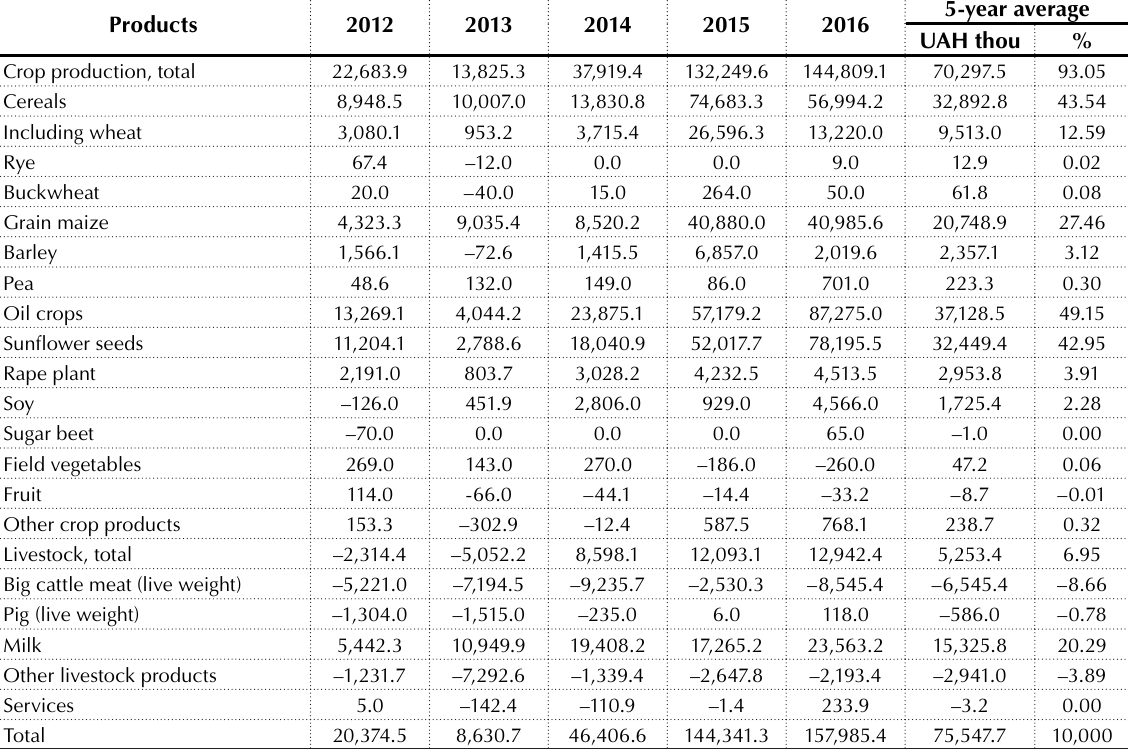
Table 9. Dynamics and distribution of profit received by agricultural enterprises of Khrystynivka district, Cherkasy region (by types of products) Source: Compiled according to the Statistical Yearbook of Ukraine